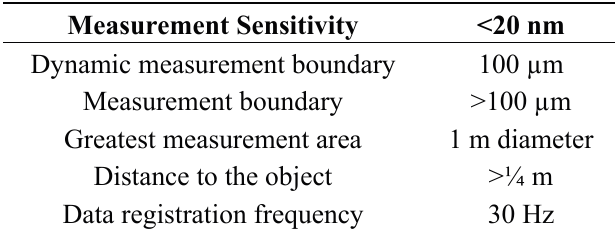
Table 1. Main characteristics of the PRISM